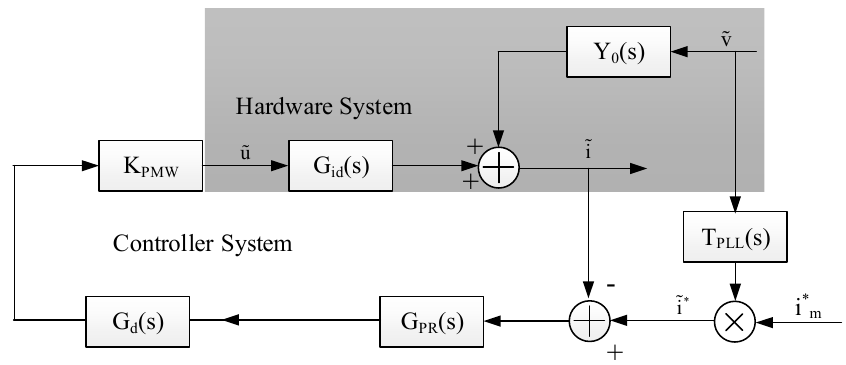
Figure 6. The small signal model of a typical PR based current control inverter.